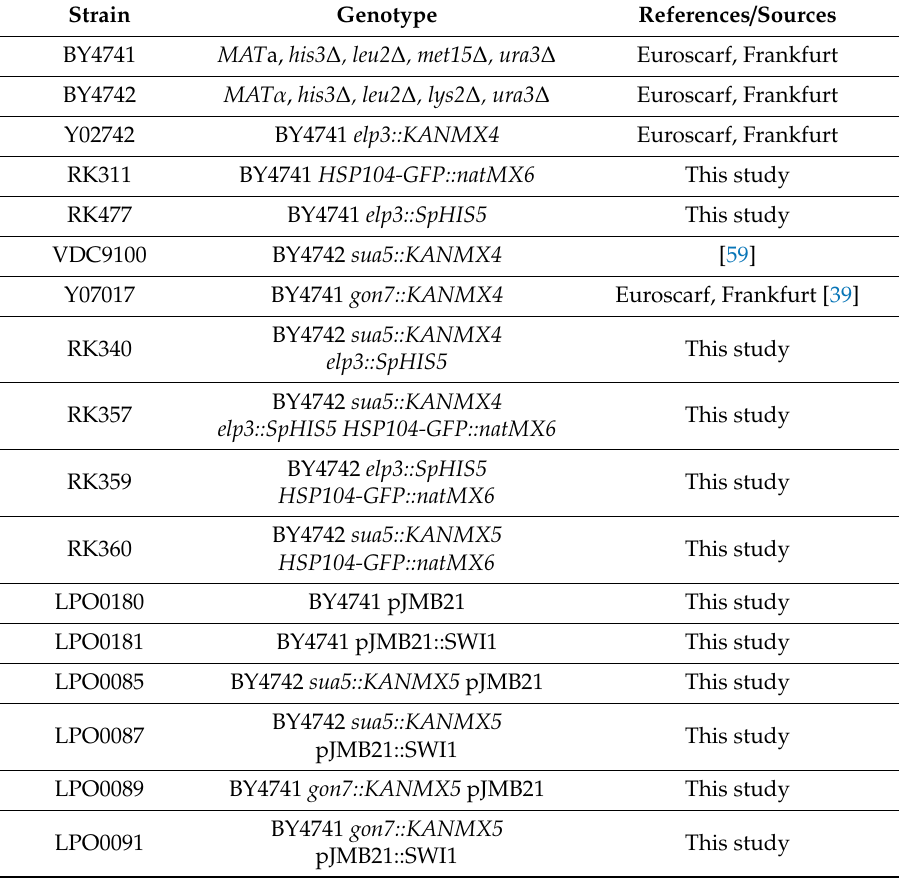
Table 1. Saccharomyces cerevisiae strains used in this